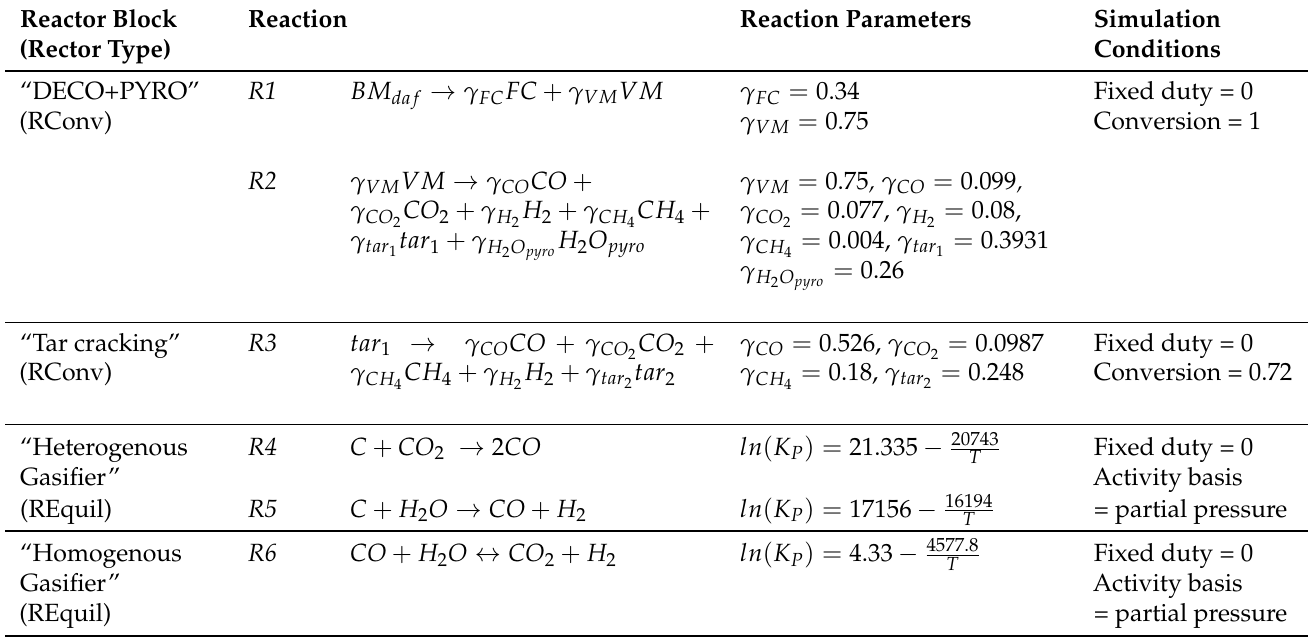
Table 2. Reaction conditions for model StoicM . The reaction parameters are taken from the literature; i.e., R1 and R2 are taken from [44], R3 from [40], R4 and R5 from [17], and R6 from [45]. T has a Kelvin